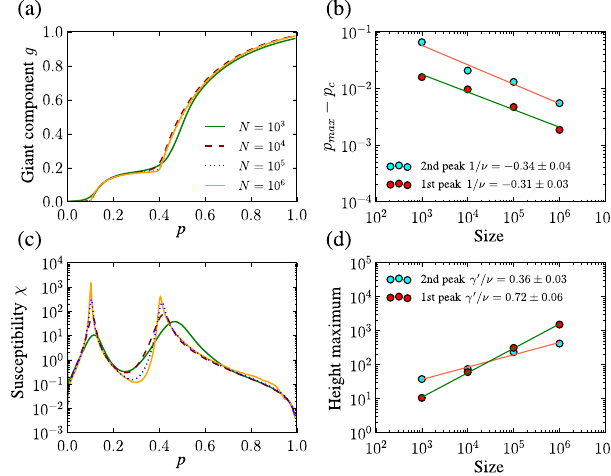
FIG. 10. Bond percolation simulations for the core-periphery random graph model for α ¼ 0 . 5 for different sizes. In both cases, ¯ 10 and the periphery the core has an average degree k c ¼ ¯ 2 . 5 . The core-periphery ratio is r ¼ 0 . 2 . (a) Relative size k p ¼ of the largest connected component as a function of the bond occupation probability p . (c) Susceptibility χ as a function of bond occupation probability p . (b, d) Position p and height max χ of the two peaks of χ as a function of network size N . The max straight lines are power-law fits. Panels (b) and (d) show the measured values of the critical exponents.